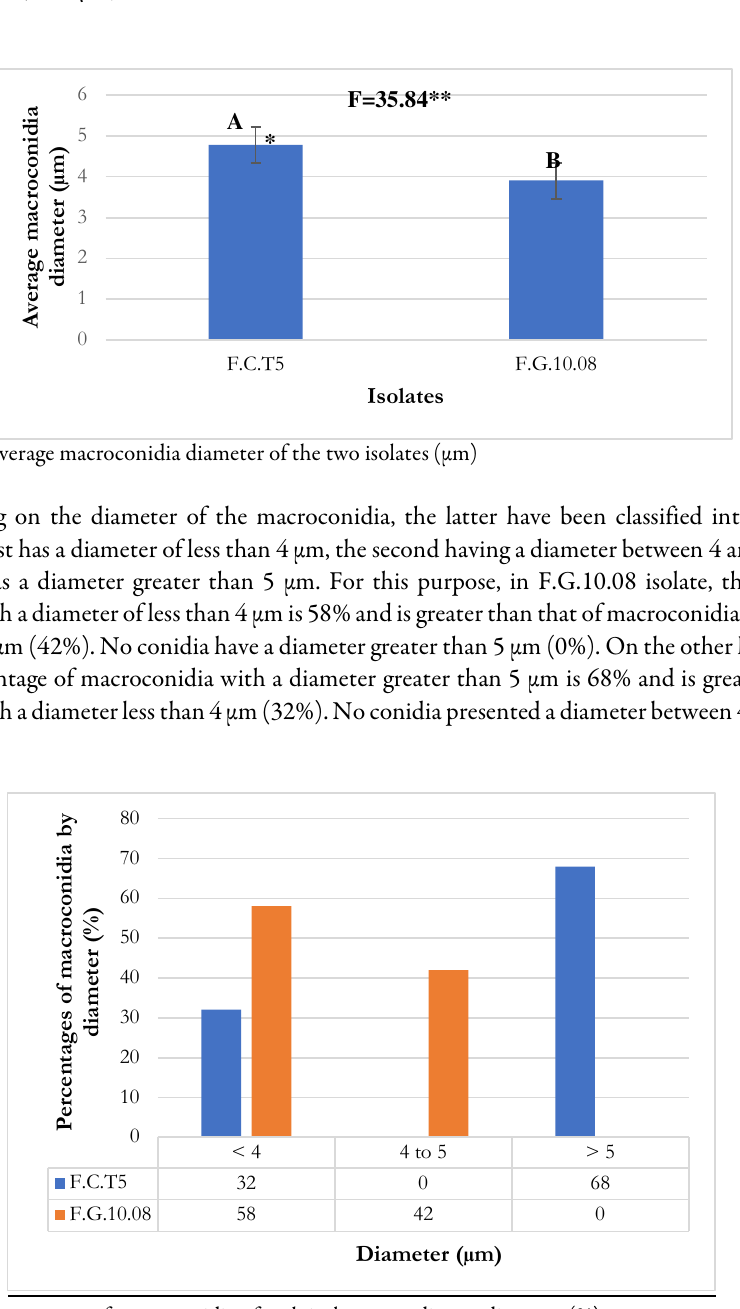
Figure 8. Figure 8.Figure 8. Figure 8. Percentages of macroconidia of each isolate according to diameter